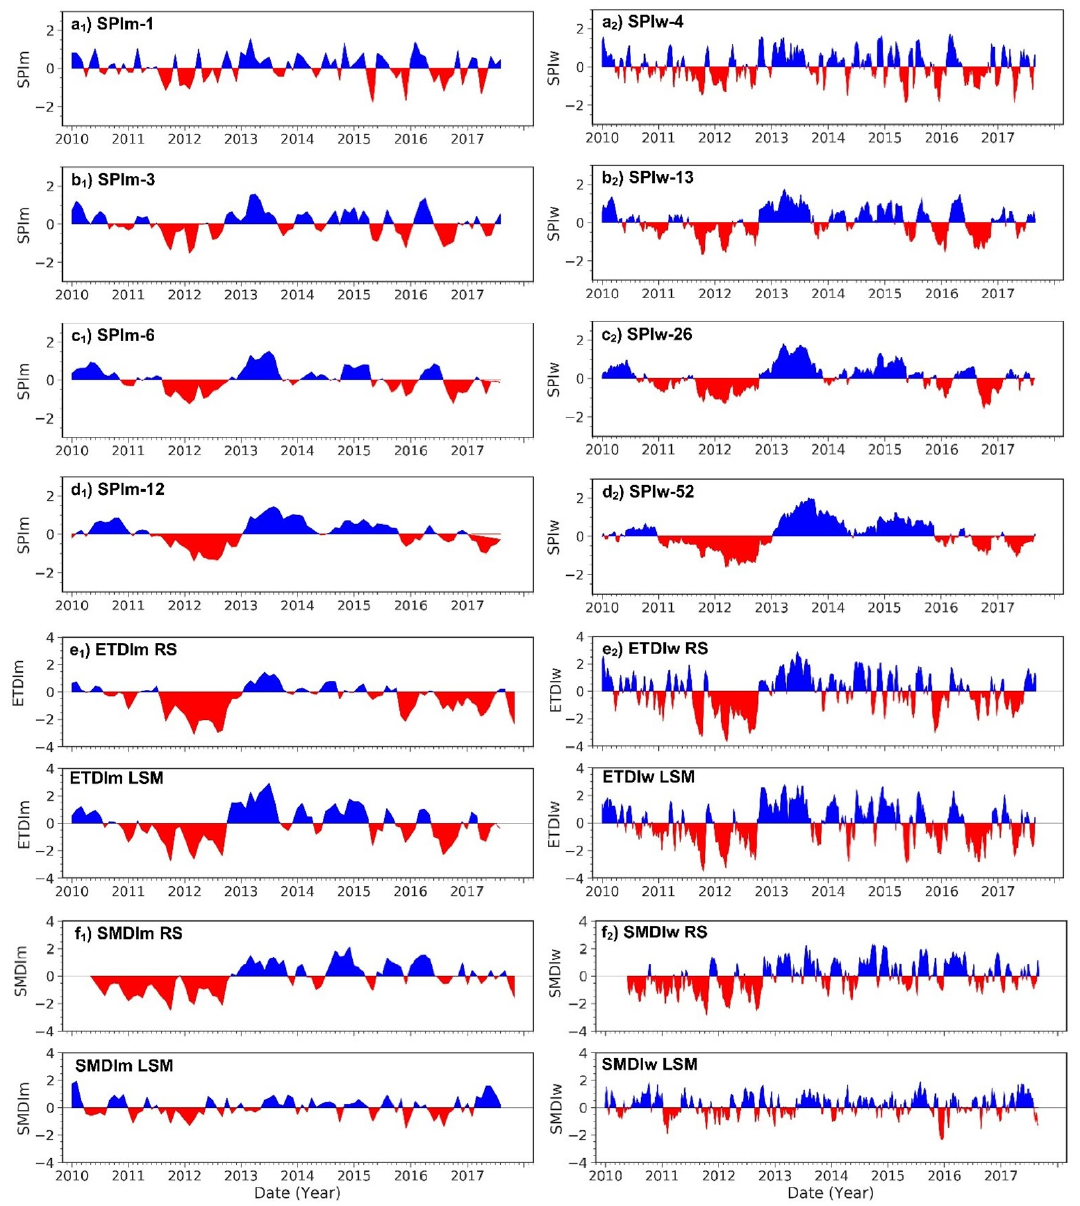
Figure 2. Time series of the SPI, ETDI and SMDI at the monthly scale (left column of subplots identified with sub-index 1) and weekly scale (right column of subplots identified with sub-index 2). Panels (a) to (d) correspond to SPIm-1, SPIm-3, SPIm-6 and SPIm-12; panels (e) and (f) display the temporal evolution of the ETDI and SMDI. These ones show two rows corresponding to the series based on RS and LSM data. Red/blue color represents dry/wet periods. Periods of drought occur when SPI < 0, ETDI > 0 and SMDI <